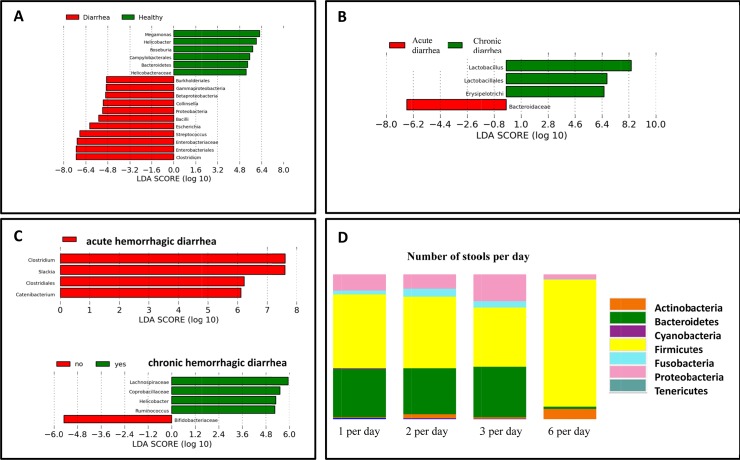
Differentially abundant bacterial groups.Results in A through C display LDA scores based on LEfSe and illustrate which bacterial groups are associated with disease type. (A) All healthy vs all diseased cats; (B) Cats with acute diarrhea vs. cats with chronic diarrhea; (C) Cats with acute hemorrhagic vs. chronic hemorrhagic diarrhea; (D) Changes in bacterial phyla based on the number of stools per day.